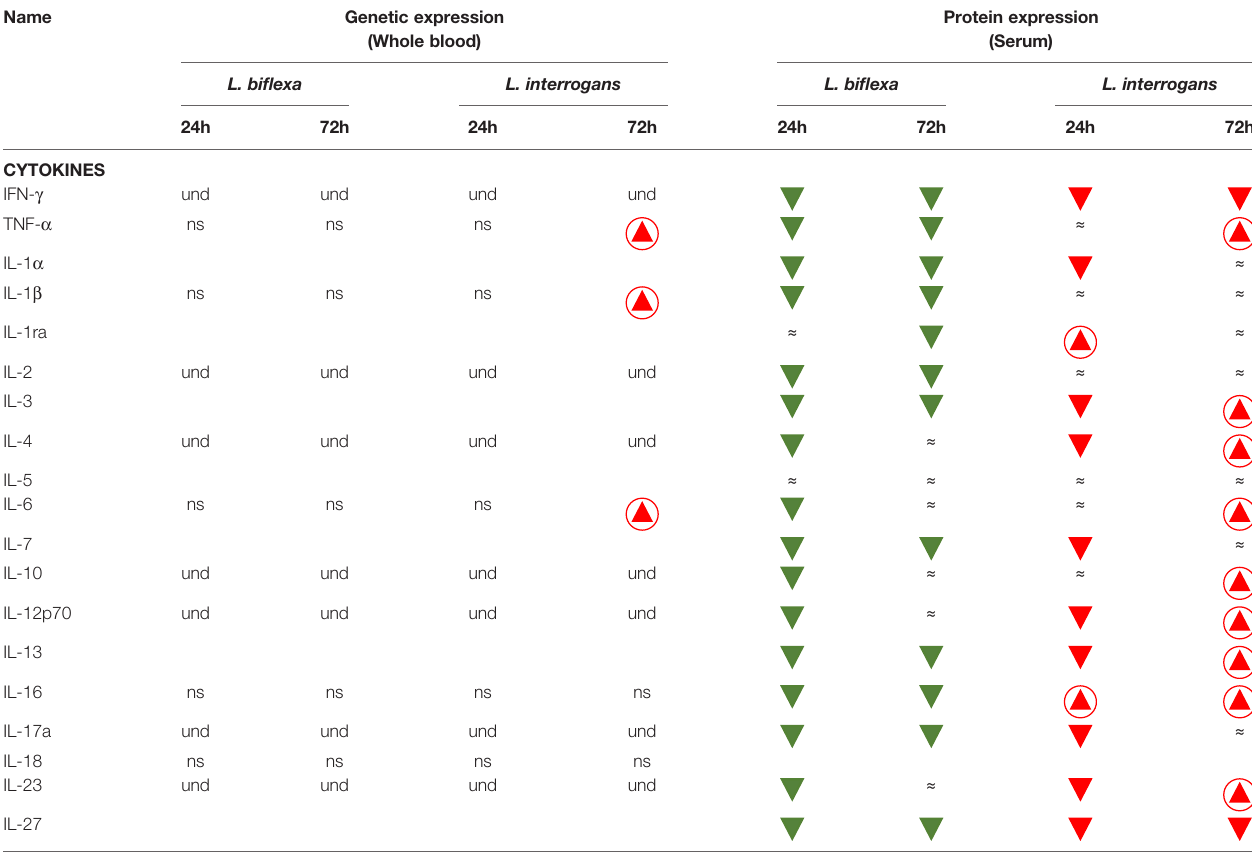
TABLE 2 | Cytokines affected during early infection with pathogenic and non-pathogenic Leptospira in comparison with control.